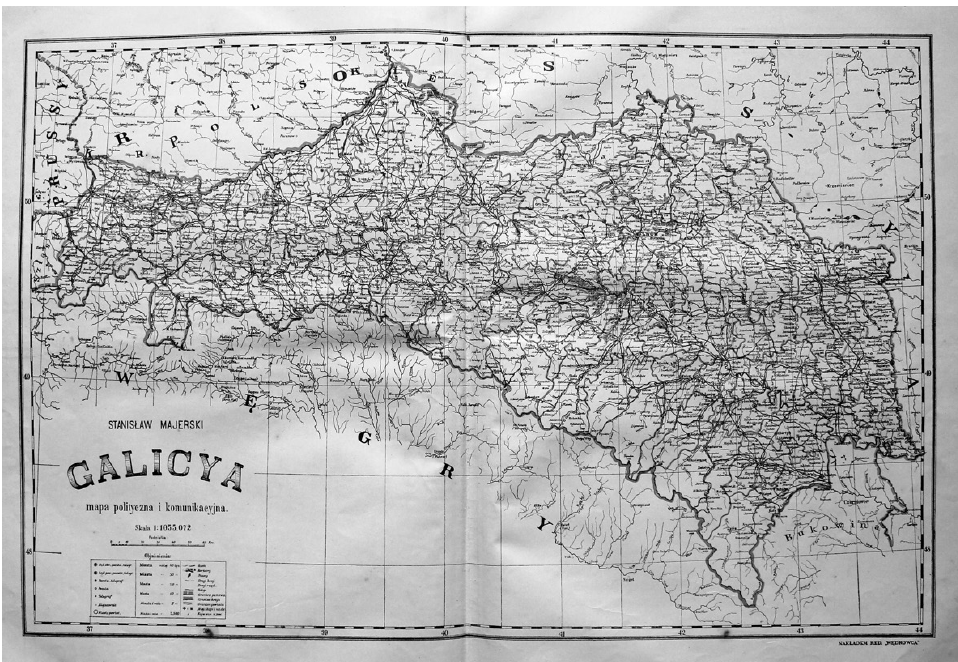
Fig. 3. The map of Galicia from Wielki Atlas Geograficzny (The Great Geographical Atlas) by W.